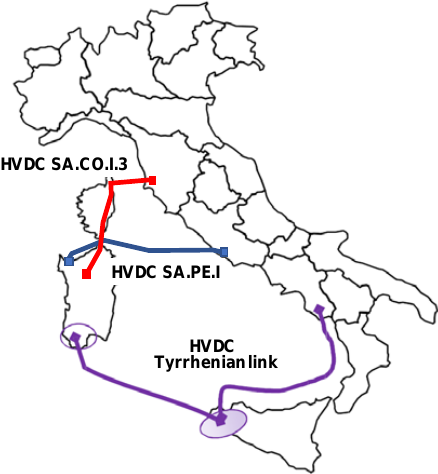
Figure 10. The option of building a new HVDC Tyrrhenian link to Sicily/Sardinia—the year 2030.